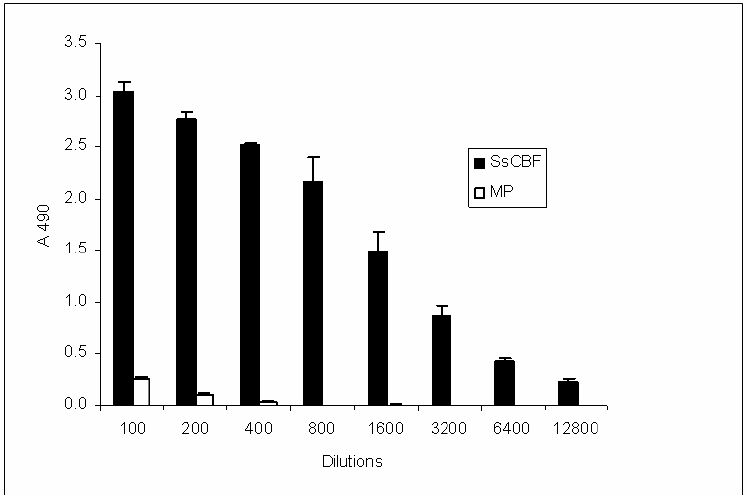
Fig. 6 – Detection of IgG antibodies against the SsCBF antigen in the synovialfluid sample from a patient with osteoarticular sporotrichosis but without exhibiting skin lesions. The synovial fluid was serially diluted (1:2) and assayed either against SsCBF or a mannoprotein from S. cerevisae (MP).